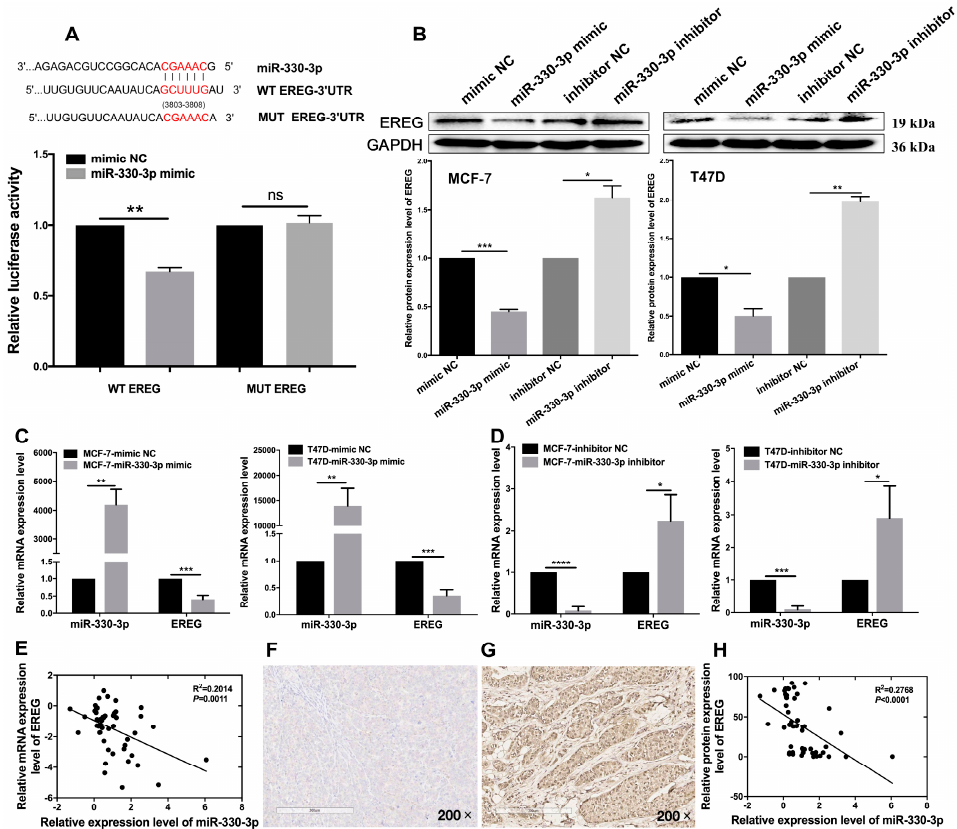
Figure 6. EREG directly interacts with miR-330-3p in BC. ( A ) Dual-luciferase reporter assay validates the predictive binding sites between miR-330-3p and EREG. ( B ) In MCF-7 and T47D cells, the effects of miR-330-3p overexpression and downregulation on EREG protein expression. In MCF-7 and T47D cell lines, effects of miR-330-3p overexpression ( C ) and miR-330-3p downregulation ( D ) on EREG mRNA expression. ( E ) The correlation analysis of changes of miR-330-3p and EREG in 50 BC patients via qRT-PCR assay. The representative IHC images of patients’ specimens with low ( F ) and high ( G ) EREG abundance based on the median of H-score of EREG protein expression. ( H ) The correlation analysis of miR-330-3p and EREG protein expressions level changes in 50 BC patients. (ns: no significant difference, * p < 0.05, ** p < 0.01, *** p < 0.001, **** p < 0.0001, n = 3).